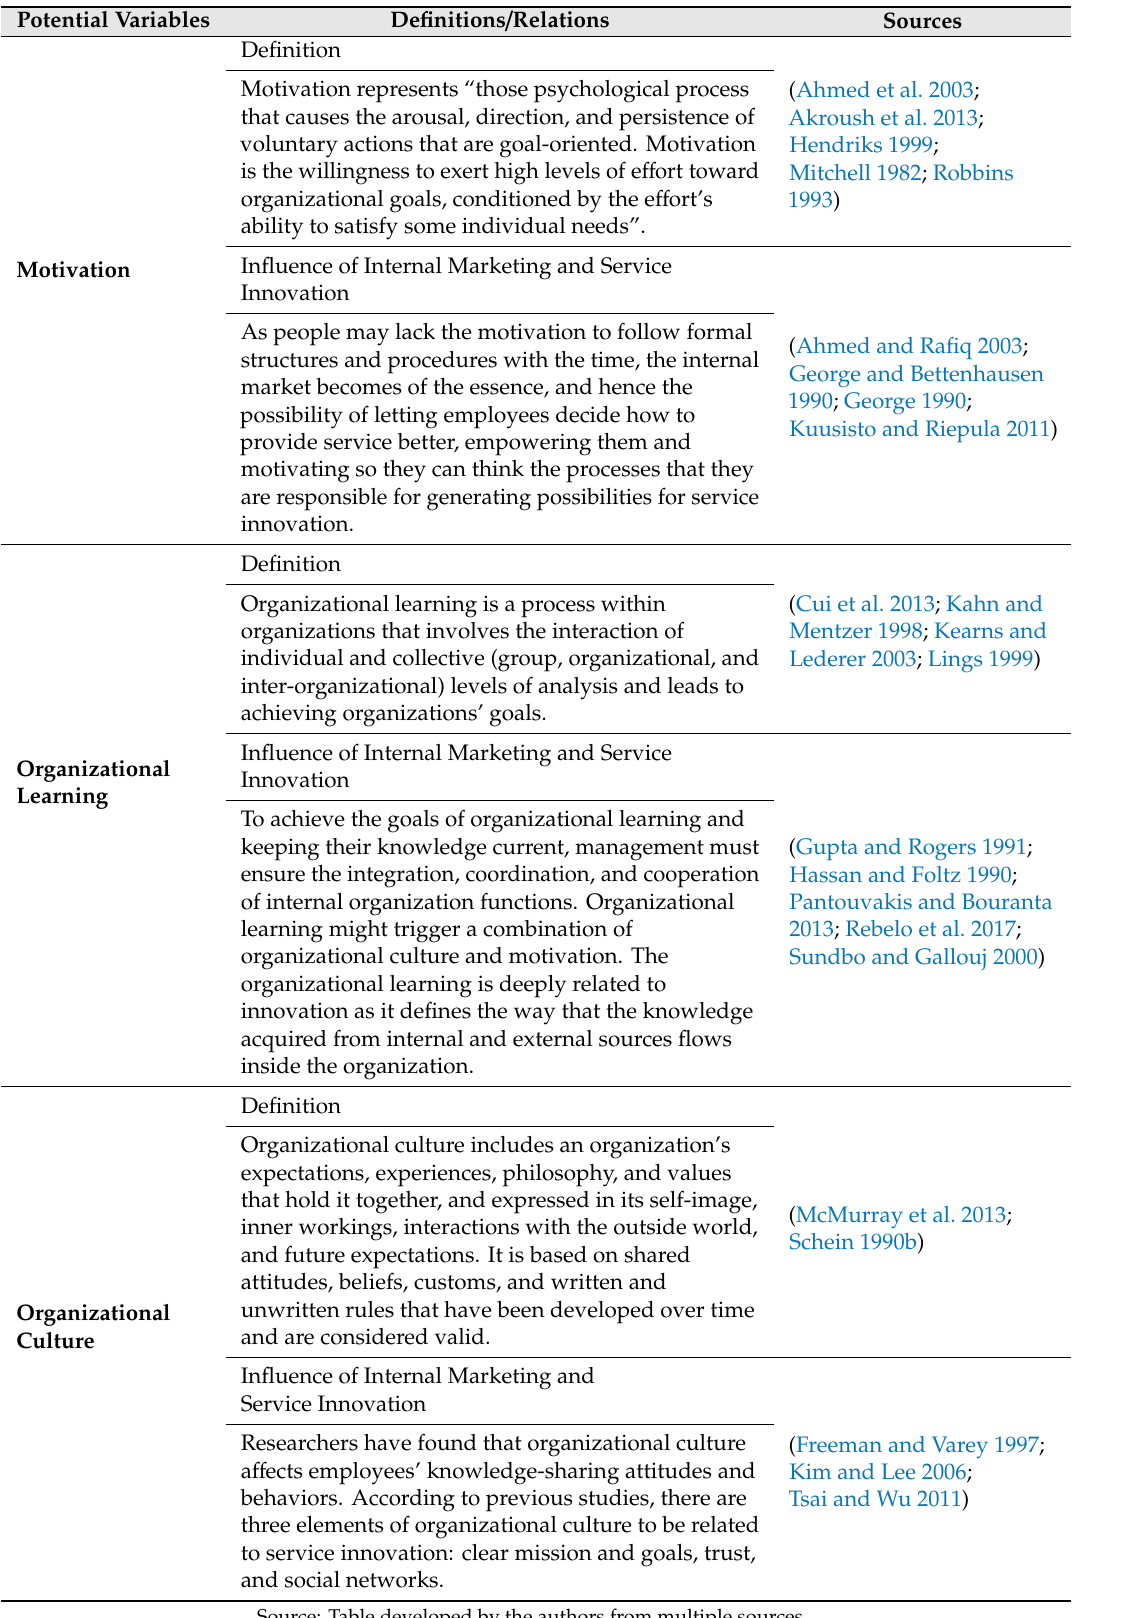
Table 6. Potential variables that emerged in internal marketing and service innovation between 1990 and